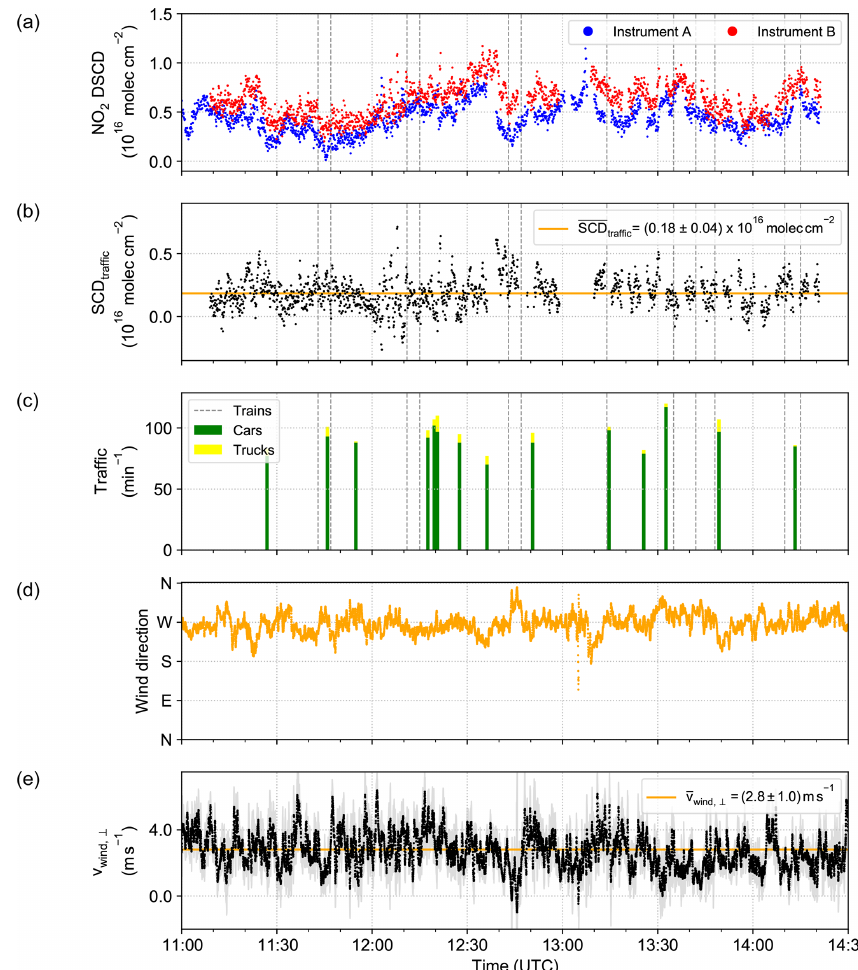
Figure 4. Time series of the measurement results of 10 May 2019. Panel (a) depicts the measured NO 2 DSCD for both measurement sites (Instrument A: west side, upwind; Instrument B: east side, downwind). In panel (b) SCD traffic , i.e. the difference between both signals, is shown. The orange line symbolises the average value. Panel (c) presents the traffic volume during the measuring duration. The number of vehicles was retrieved by counting from the videos over 1min intervals on a sample basis. The dashed grey lines represent the times of passing trains. Panel (d) depicts the wind direction as measured by the weather station. Panel (e) shows the wind velocity v wind , ⊥ perpendicular to the viewing direction of the Tube MAX-DOAS instruments. The orange line denotes the mean value over the whole measurement period. Here, the light-grey values depict the error (cid:49)v wind , ⊥ of the calculated wind